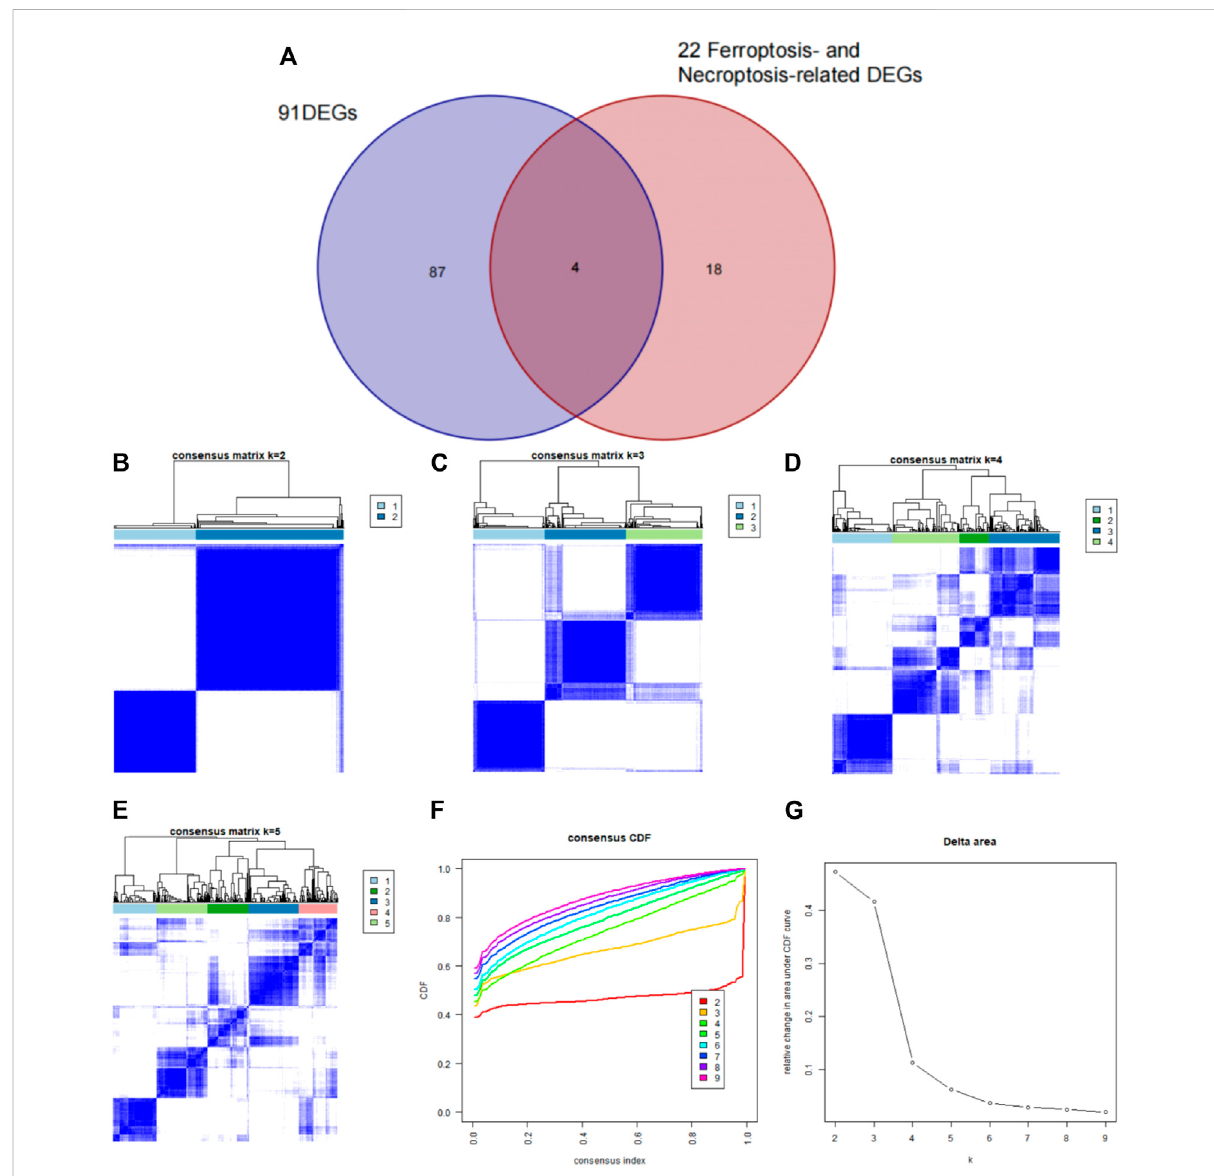
FIGURE 9 Identi fi cation of subgroup-speci fi c genes in the two clusters and consensus clustering of the four subgroup-speci fi c genes in patients with CAD. (A) The four subgroup-speci fi c genes were identi fi ed by intersection of 22 ferroptosis- and necroptosis-related DEGs and DEGs between the two clusters. (B – E) Consensus matrices of the four subgroup-speci fi c genes for k = 2 – 5. (F) CDF curve for k = 2 – 9. (G) Delta area score of the CDF curve for k = 2 –